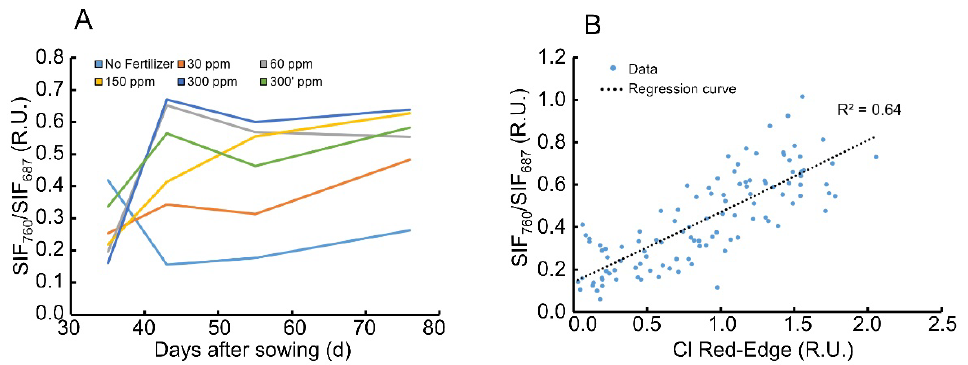
Figure 4. Attenuation of the SIF ratio along the season and a gradient of fertilization treatments. ( A ) Fertilization treatments were colored light blue, orange, grey, yellow, blue and green and relate to the negative control without fertilizer, 30, 60, 150, 300, 30 0′ ppm N content, respectively. n = 5 acquired in quadruplicates. Measurements were taken along the season. Differences were determined between points at a statistical significance of p < 0.05; and ( B ) correlation plot between the ratio of SIF and total chlorophyll index across all fertilization treatments and dates.